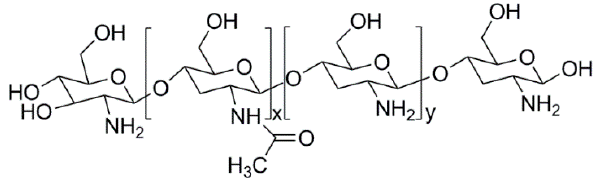
Figure 2. Structure of chitosan.